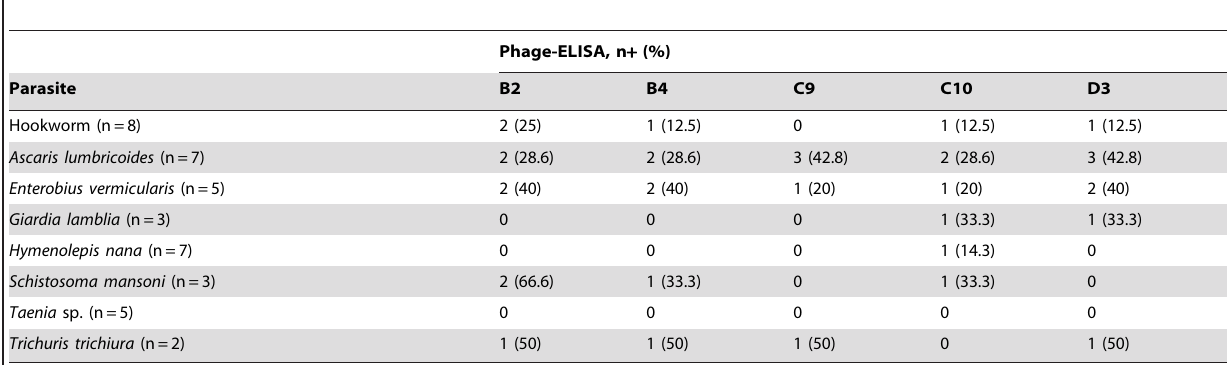
Table 2. Cross-reactivity of sera from patients with other parasitic diseases (Group II, n =40) by Phage-ELISA for detection of immunoglobulin G (IgG) to S. stercoralis using the selected phage clones.